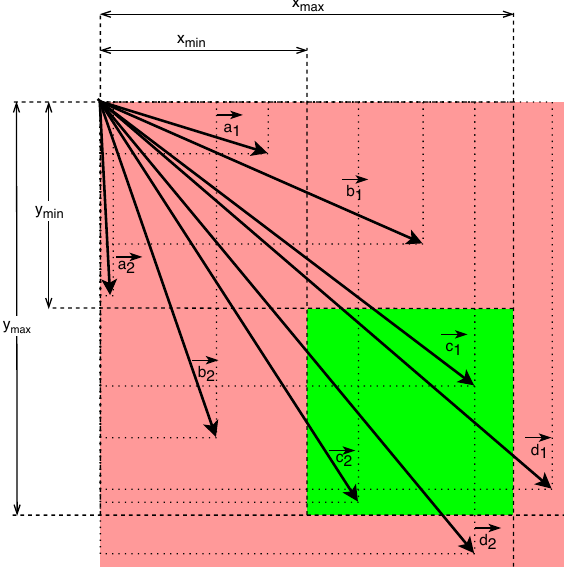
Figure 23. Illustration of filtering of the objects found according to the dimensions of their rectangular delimitations described by a descriptive